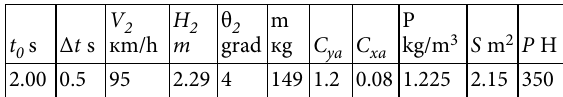
Table 1. Initial data for